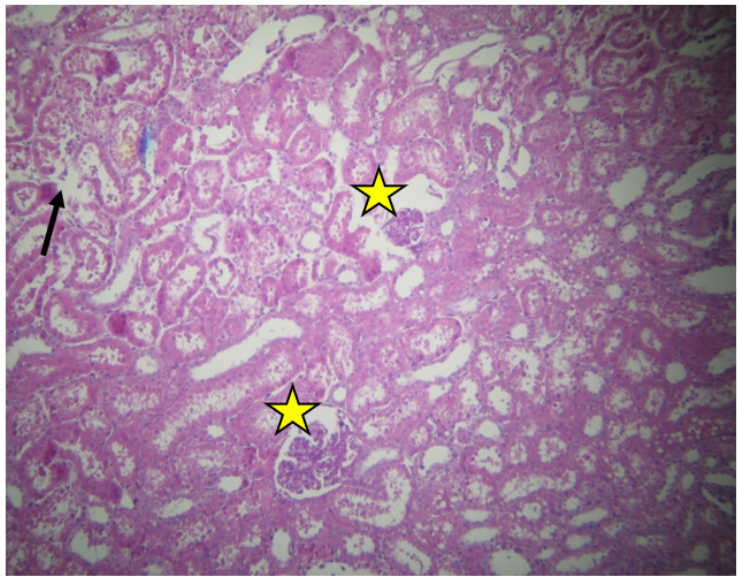
Figure 1. Cortex of non-resuscitated swine stained with HE. Renal corpuscles with abnormal urinary space (yellow stars). Destroyed tubular epithelium (black arrow), ×40.